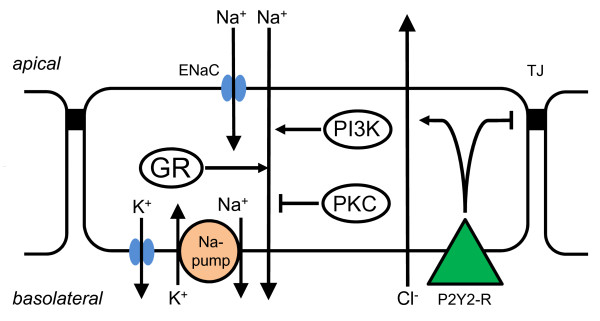
Proposed cell model for P2Y, PKC and PI3-K regulation of ion transport by SCCD epithelium. Na+ is absorbed from endolymph by entry into the cytosol across the apical membrane via the epithelial Na+ channel (ENaC). Na+ is removed from the cytosol across the basolateral membrane by the Na+, K+-ATPase (Na+-pump); K+ entering the cell on the Na+, K+-ATPase recycles across the basolateral membrane via K+ channels. Activity of this Na+ absorptive mechanism is stimulated by activation of the glucocorticoid receptor (GR), by activity of phosphoinositide-3 kinase (PI3-K) and inhibited by activity of protein kinase C (PKC). Activation of the P2Y2 receptor (P2Y2-R) in the basolateral membrane reduces the barrier to ions of the tight junctions (TJ) and stimulates Cl- secretion.